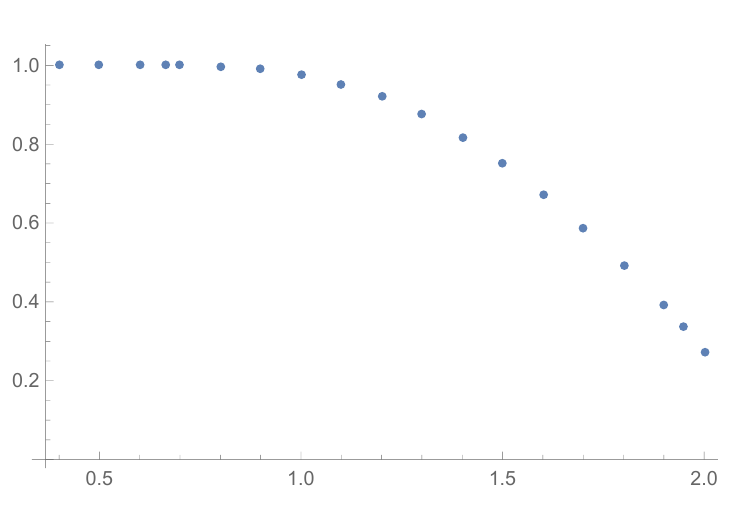
Figure 6. γ 2 ( n / m )